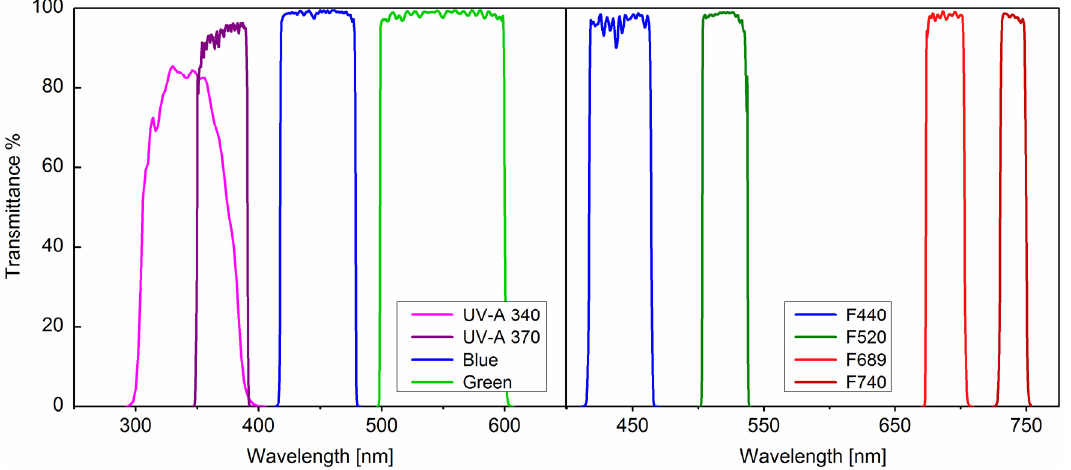
Figure 6. Transmittance spectra of the filters for excitation and detection in the two filter wheels. Excitation (Left): Two UV-A filters, a blue, and a green filter in front of the xenon lamp are producing different kind of light for fluorescence excitation; Detection (Right): Four filters for recording of blue, green, red, and far-red fluorescence bands are mounted in front of the